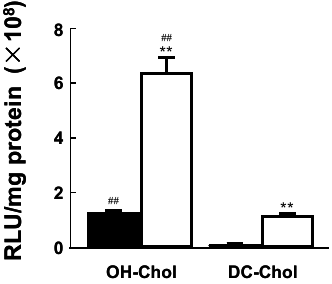
Figure 3. Effects of the liposome vectors with MEL-A on the transfection efficiency in target cells. NIH-3T3 cells were transfected with luciferase gene (pGL3) using two different cationic cholesterol derivatives, OH-Chol and DC-Chol without MEL-A (black bars) and with MEL-A (white bars). Transfection efficiency was measured by luciferase assay and values were normalized to the amount of total protein. Values are mean ± S.E. ( n = 3). ** p < 0.01 compared with cationic liposomes without MEL-A; ## p < 0.01 compared with DC-Chol by Students t test, respectively. The details were described in our previous paper